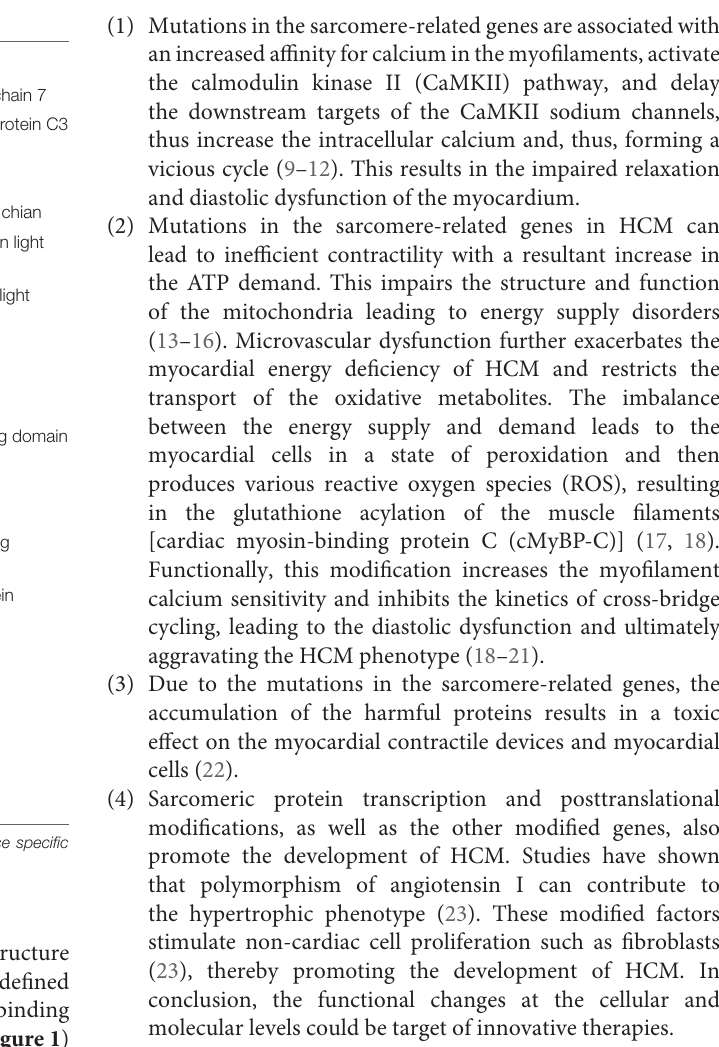
TABLE 1 | A list of the genes in which the pathogenic mutations are associated with hypertrophic cardiomyopathy (HCM). Gene HCM frequence Protein or associated Sarcomeric